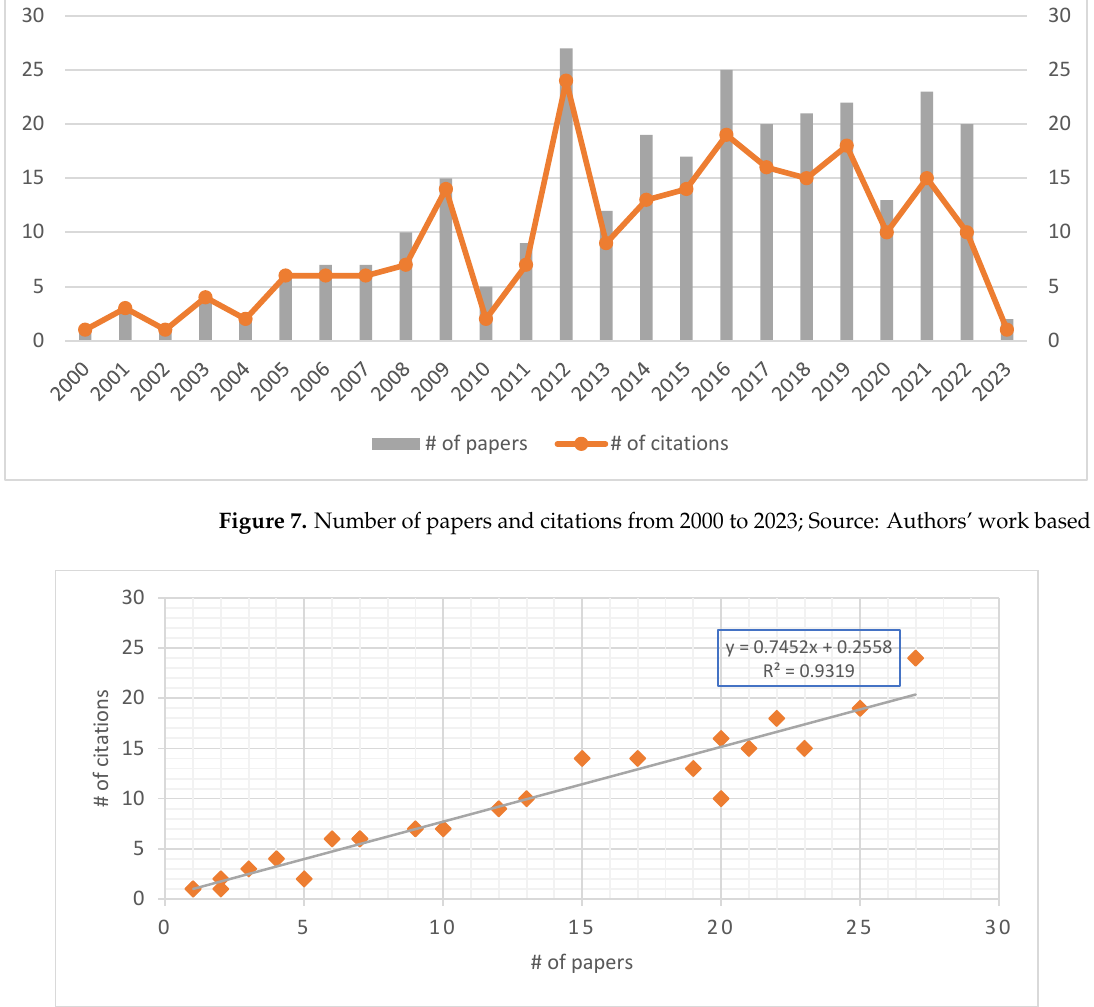
Figure 8. Scatter plot of the number of papers and citations from 2000 to 2023; Source: Authors’ work based on Scopus. Table 4. Number of citations of the top 10 most cited